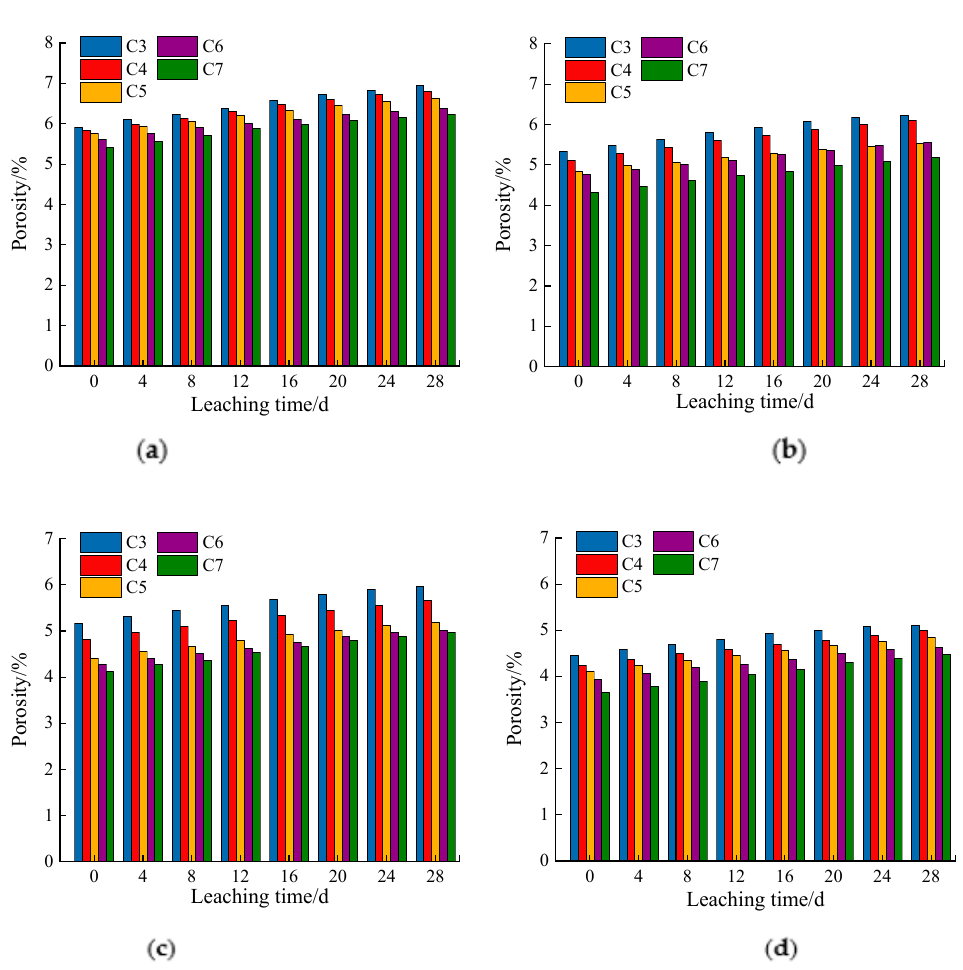
Figure 7. Porosity changes of samples with different cement dosages: ( a ) cement:fly ash = 1:0; ( b ) cement:fly ash = 1:0.1; ( c ) cement:fly ash = 1:0.2; ( d ) cement:fly ash = 1:0.3.